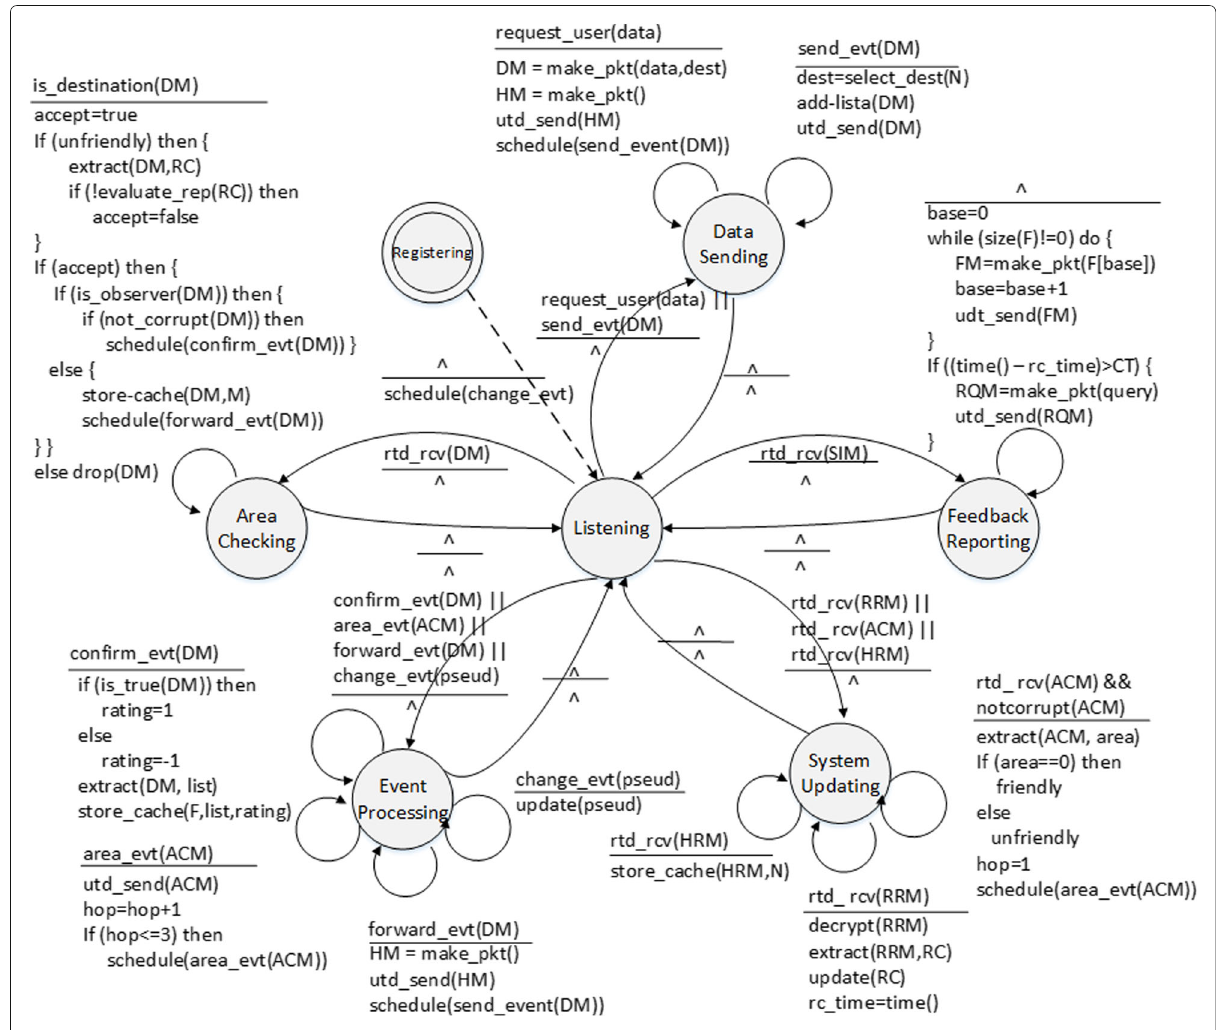
Fig. 4 Finite state machine of the